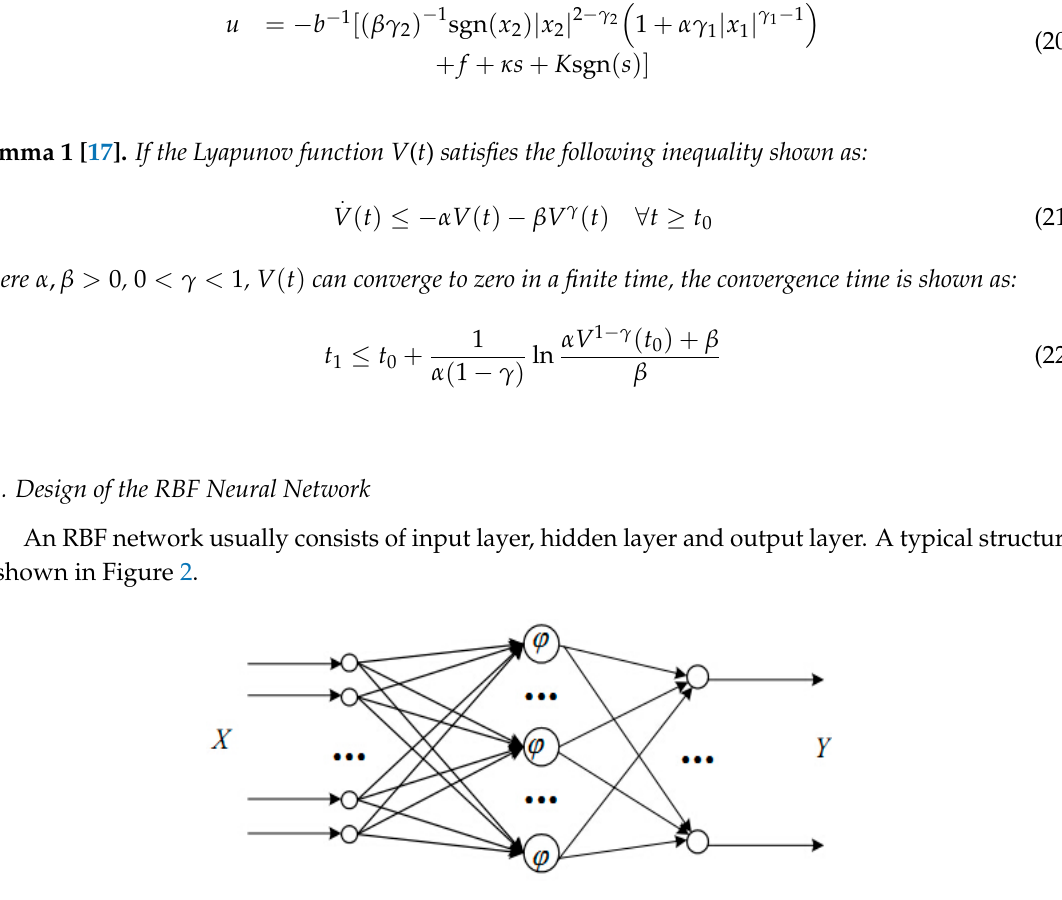
Figure 2. RBF neural network structure diagram.